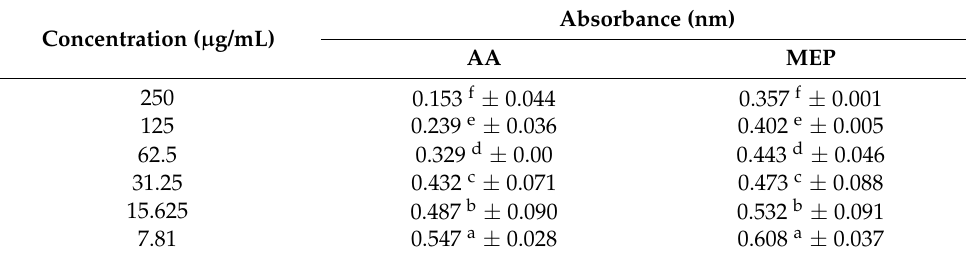
Table 1. Spectrophotometrically recorded absorbance in DPPH assay.